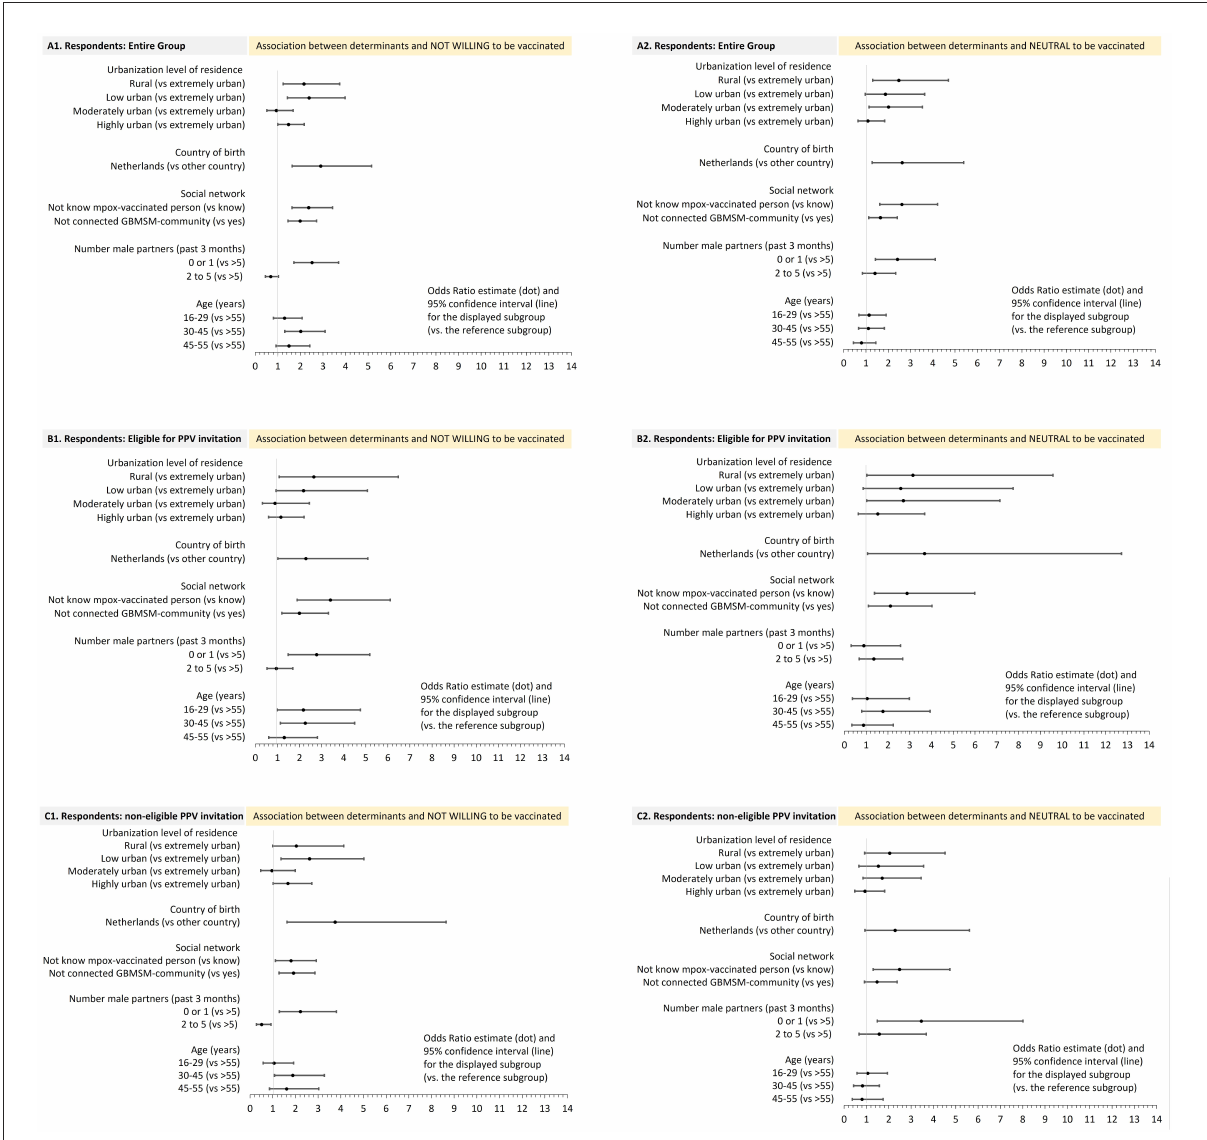
FIGURE2 Sociodemographic, social environment, and behavioral determinants and their association with being not willing, or neutral, to accept mpox vaccination when offered, (compared to being willing), in multivariable multinominal regression analyses, mpox unvaccinated GBMSM/TGP participating in the Dutch online mpox-survey (22 July-5 Sept 2022). (A1, A2) entire group; (B1, B2) PPV eligible; (C1, C2) PPV